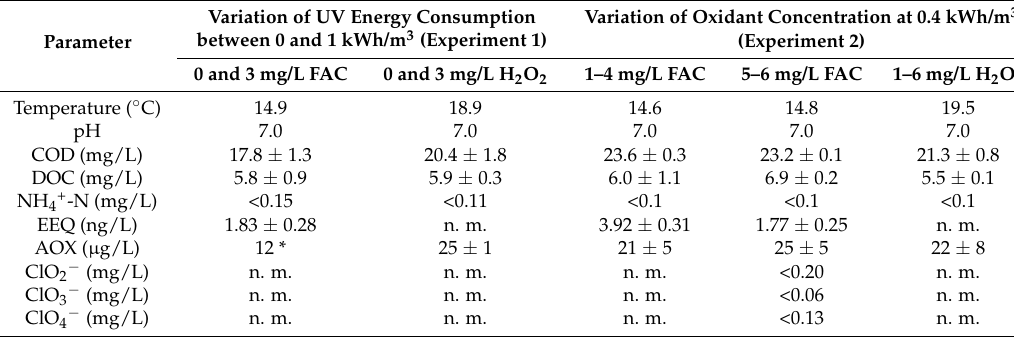
Table 1. Initial parameter values c 0 measured in WWTE reference samples collected in both UV/chlorine AOP and UV/H 2 O 2 AOP experiments (n. m.: not measured; COD: chemical oxygen demand; DOC: dissolved organic carbon; EEQ: 17 β -estradiol equivalent; AOX: adsorbable organohalogens; * only one